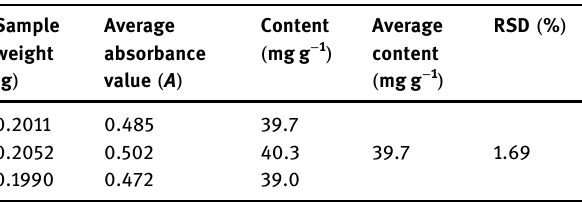
Table 2: Result for polysaccharide determination of B. rynchopetera extract Sample